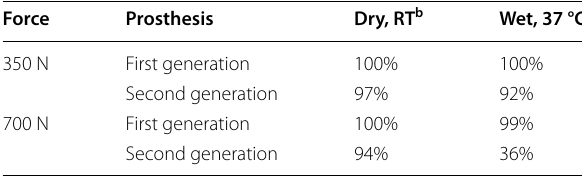
Table 1 Load sharing a in the artificial knee